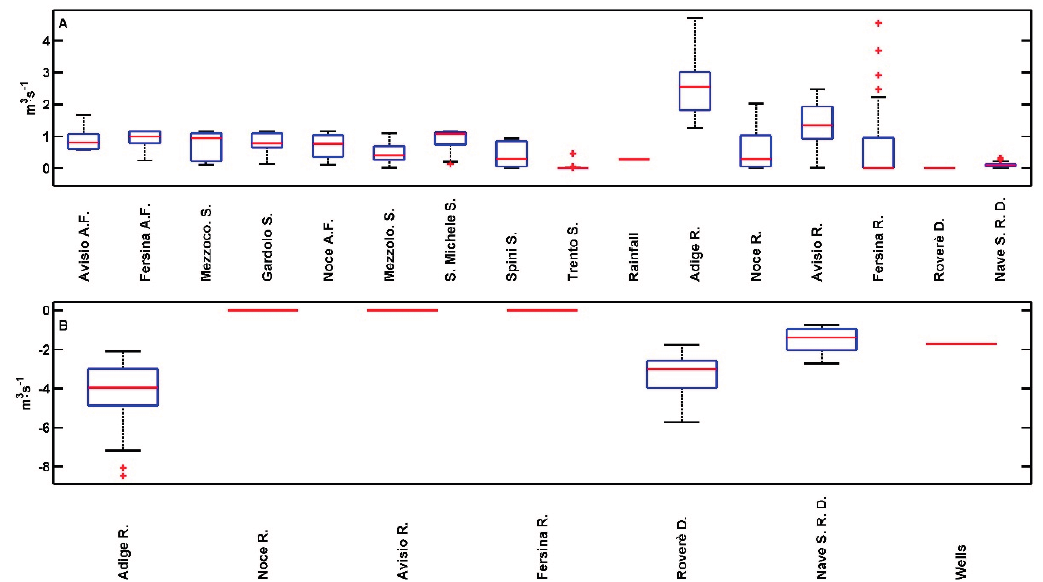
Figure 8. ( A ) Boxplots of the recharge of the aquifer; ( B ) Boxplots of the discharge from of the aquifer.